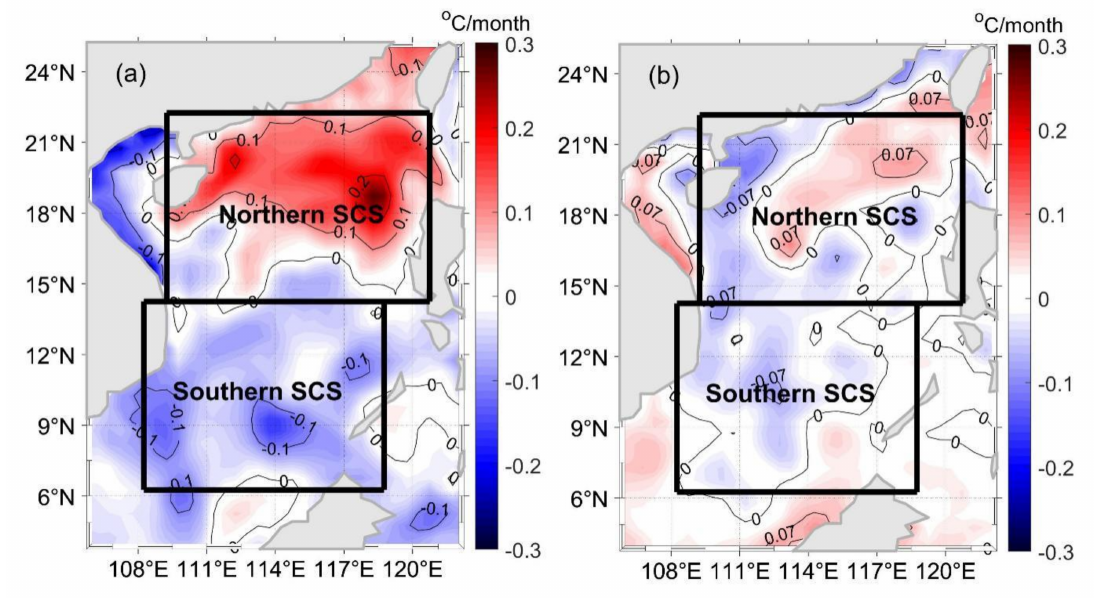
Figure 4. The mean SCS SST tendency in the spring of El Niño decaying years for the ( a ) EP El Niño and ( b ) CP El